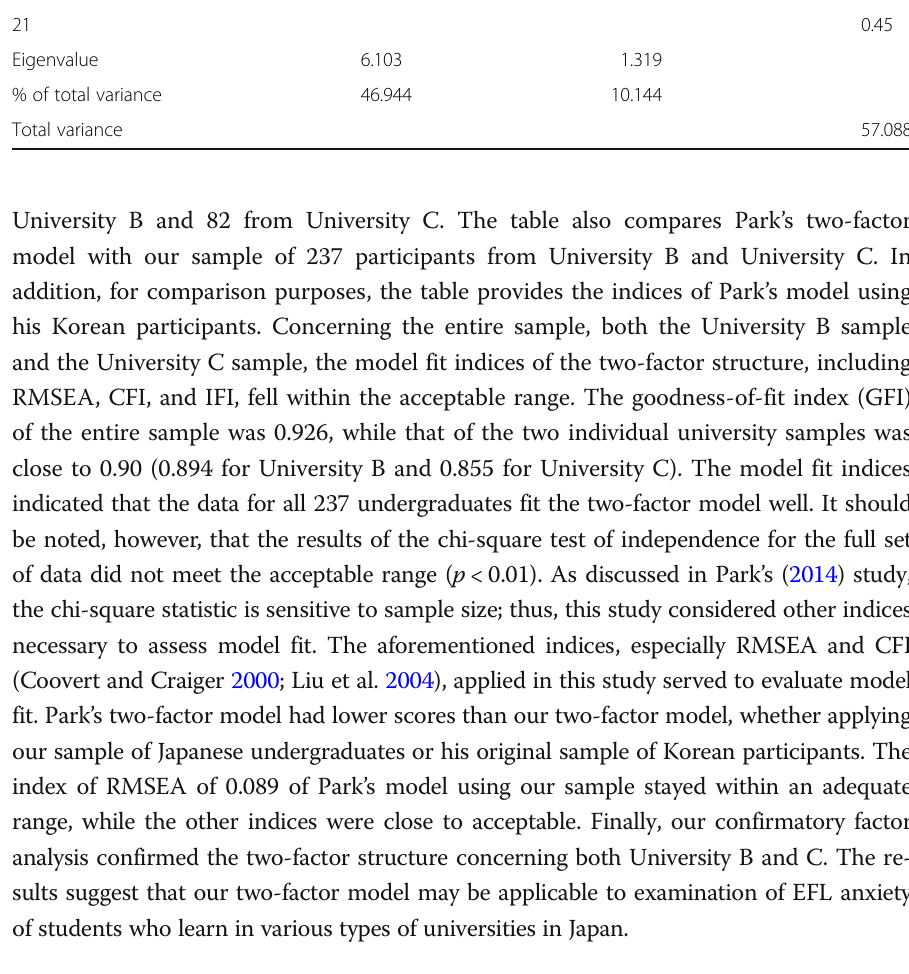
Table 5 Results of the third exploratory factor analysis of the FLCAS with direct oblimin rotation ( n = 149) Item